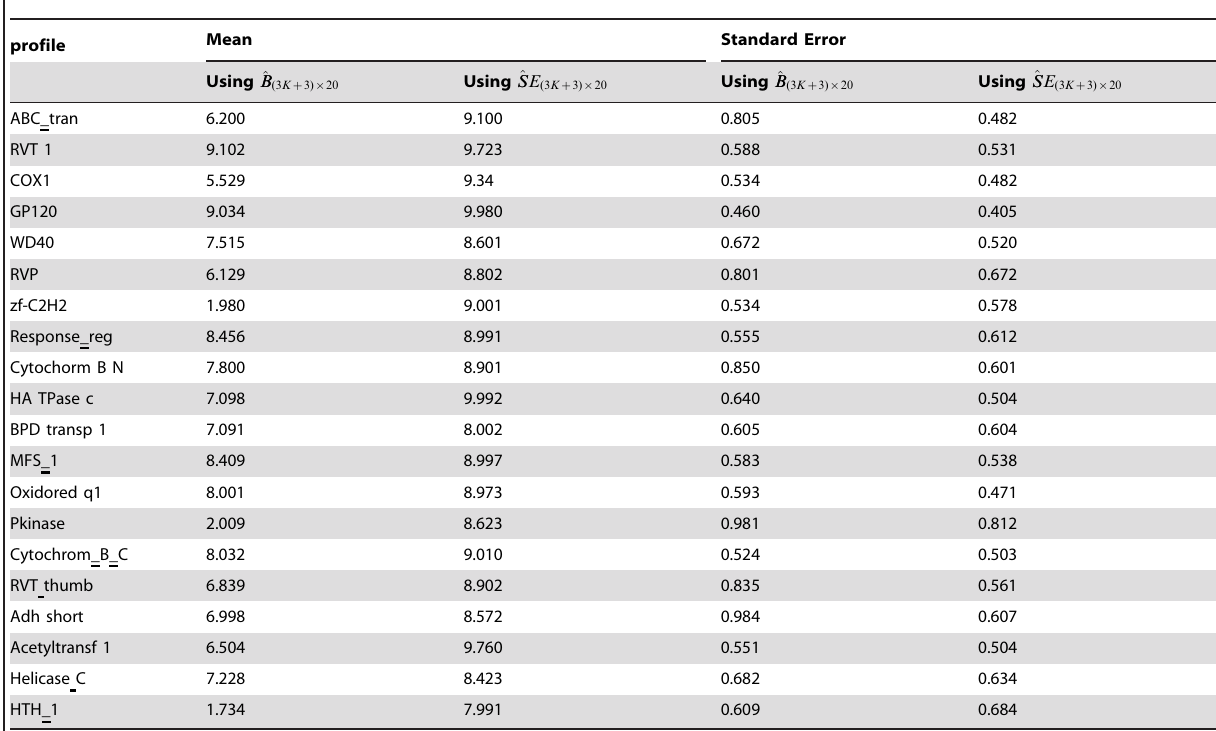
Table 3. The mean and standard error of the numbers of correctly assigned